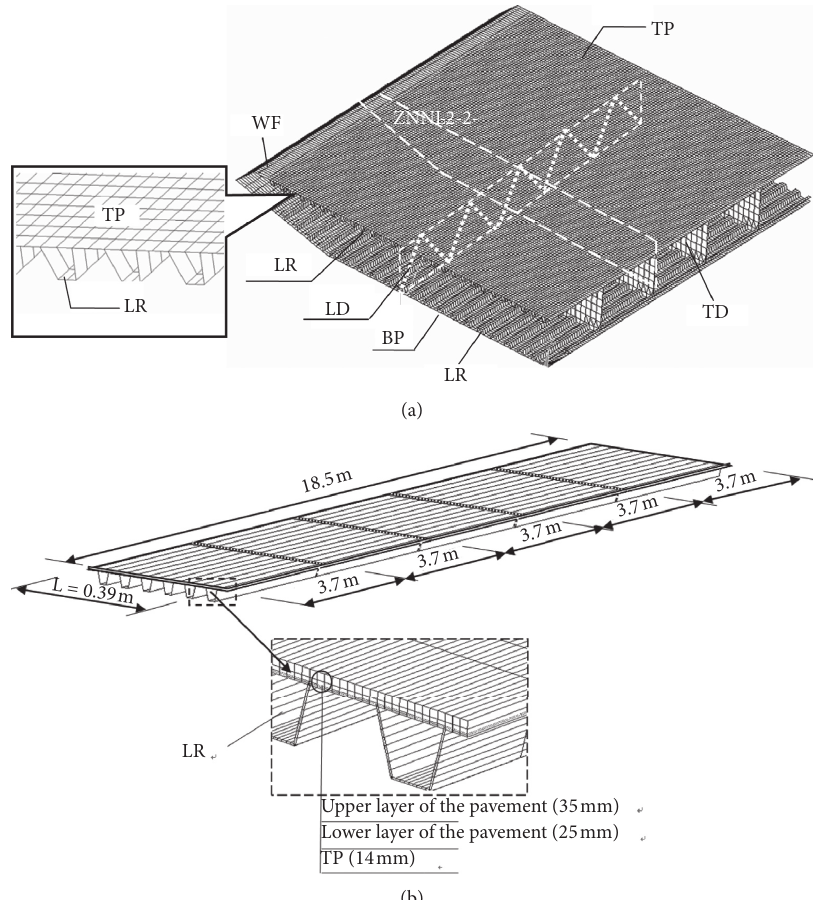
Figure 1: The finite element model: (a) the original model and (b) the simplified model.